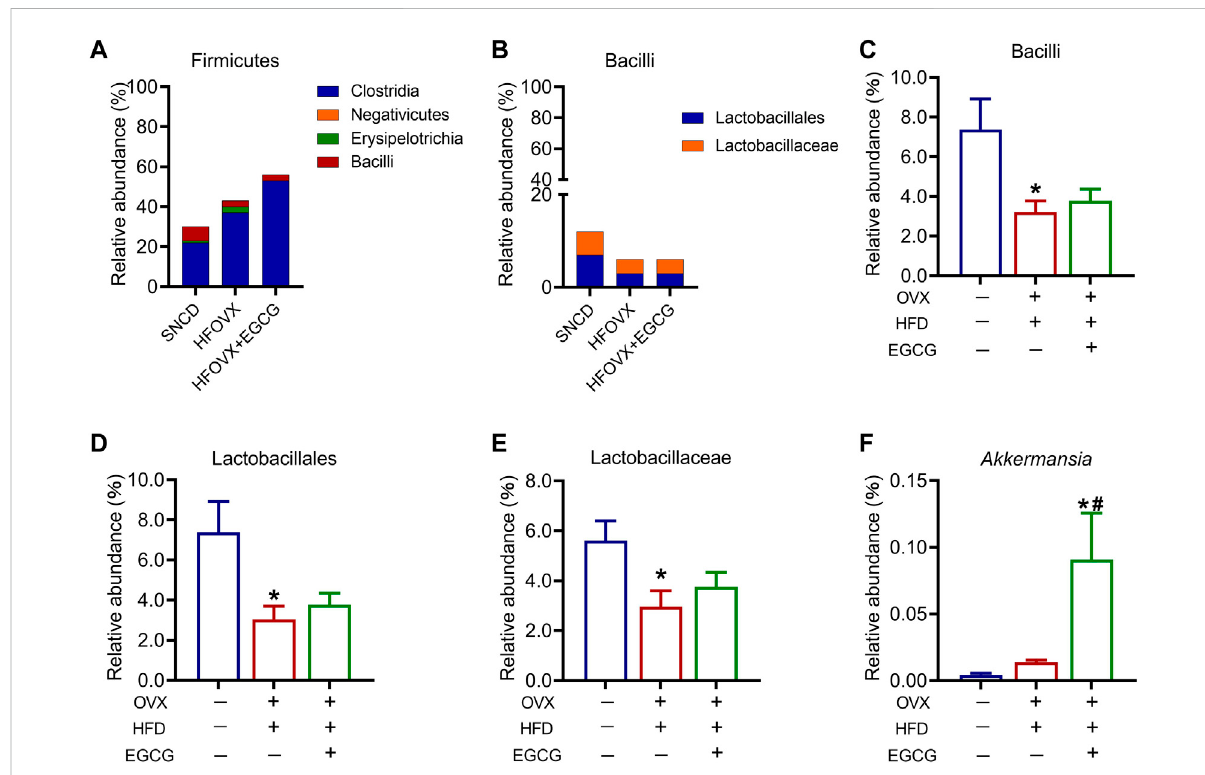
FIGURE 6 Different abundances of gut microbiota in the Firmicutes and Verrucomicrobia . (A – B) Relative abundance of the composition of Firmicutes (A) and Bacilli (B) . (C – F) Relative abundance of Bacilli (C) , Lactobacillales (D) , Lactobacillaceae (E) , and Akkermansia (F) in the three groups. * p